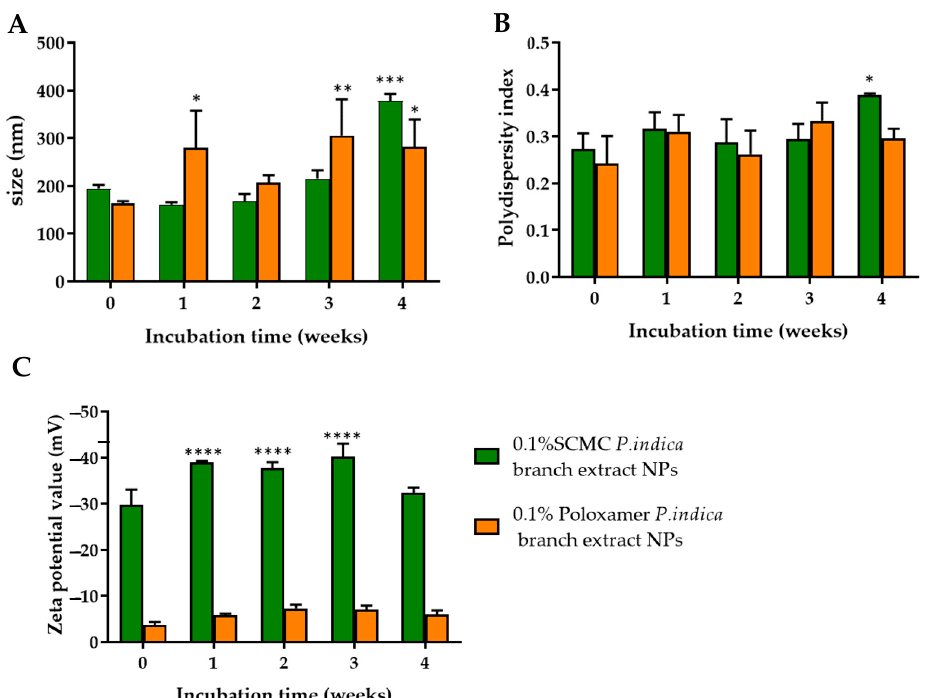
Figure 2. ( A ) Hydrodynamic diameter ( B ) polydispersity index and ( C ) zeta potential values of P. indica branch extract NPs after fresh preparation and storage in deionized water for 1, 2, 3, and 4 weeks at 4 °C. The data represent mean ± SD of three experiments. *, **, ***, and **** in dicate p < 0.05, p < 0.01, p < 0.001, and p < 0.0001 compared with day 0, respectively.